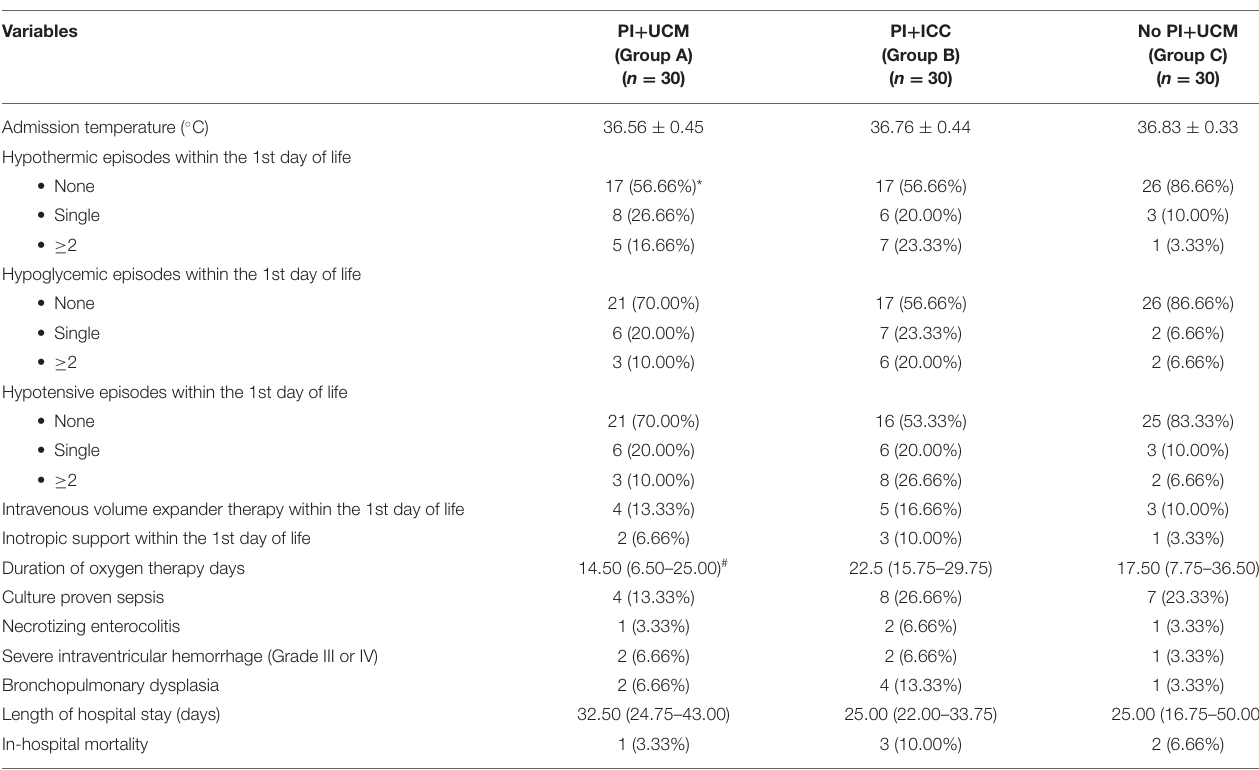
TABLE 3 | NICU course between